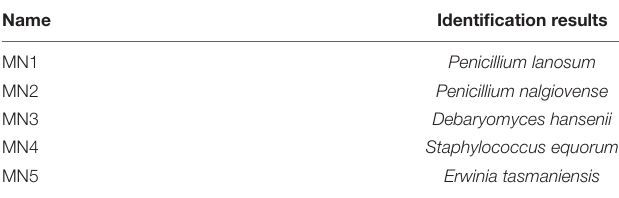
TABLE 5 | Identification results of five strains isolated from Mianning ham.